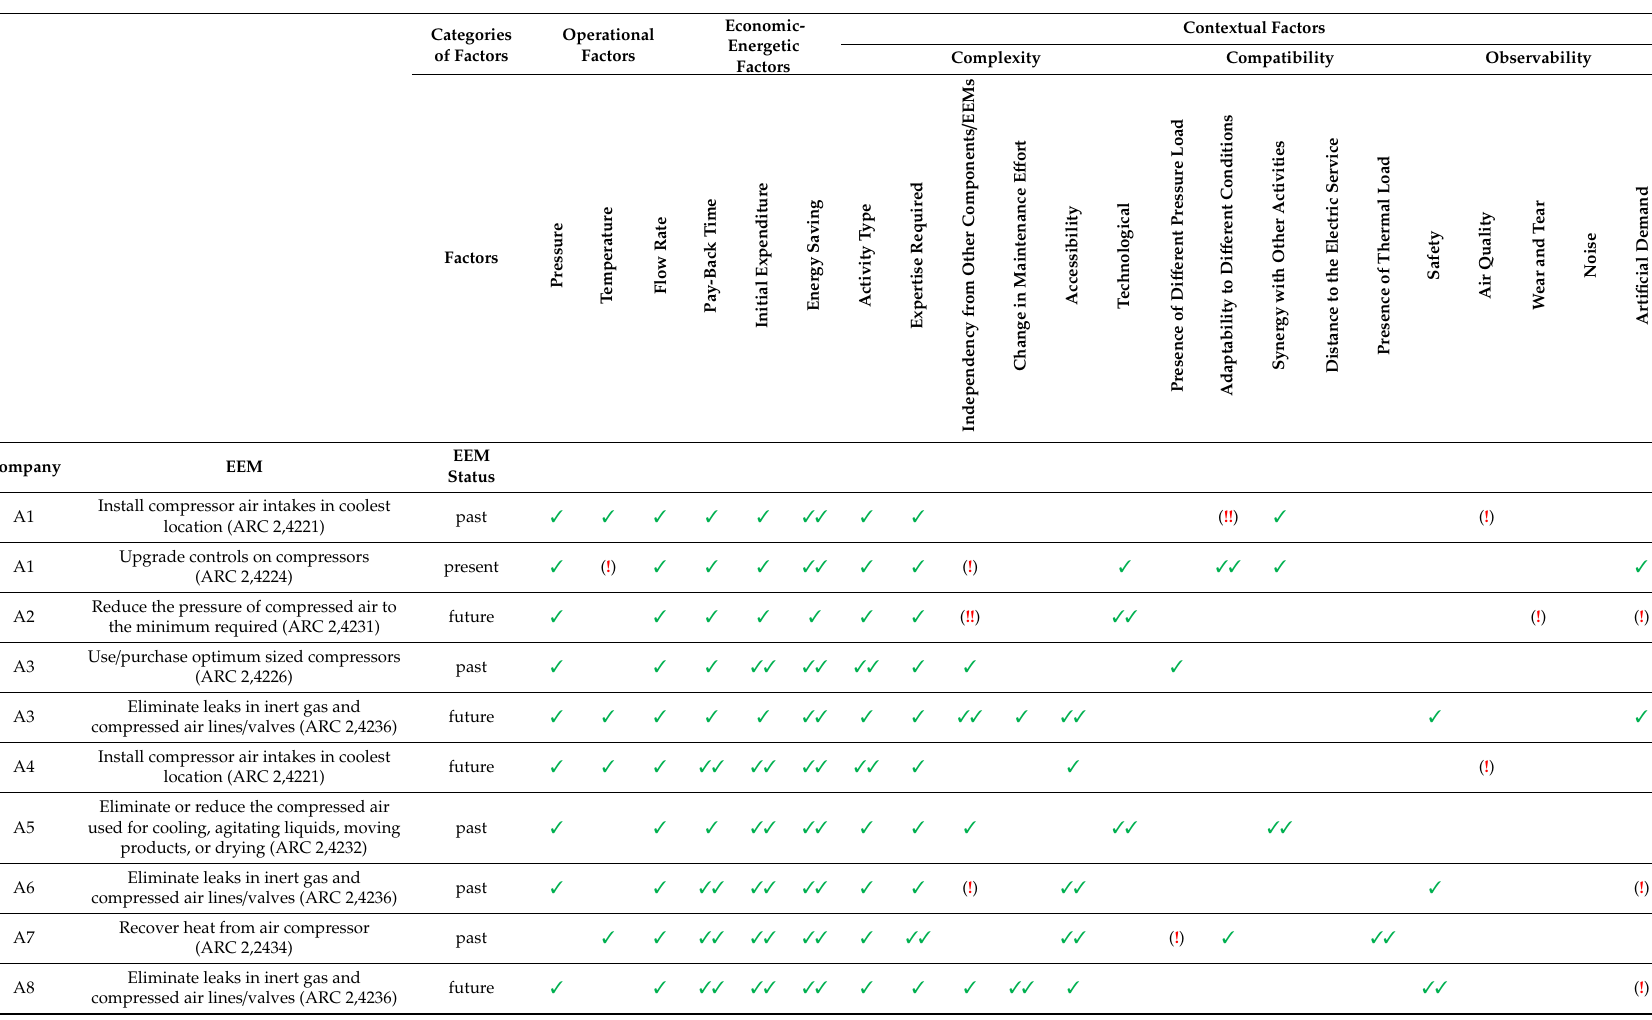
Table 9. Assessment of the factors from the application of the